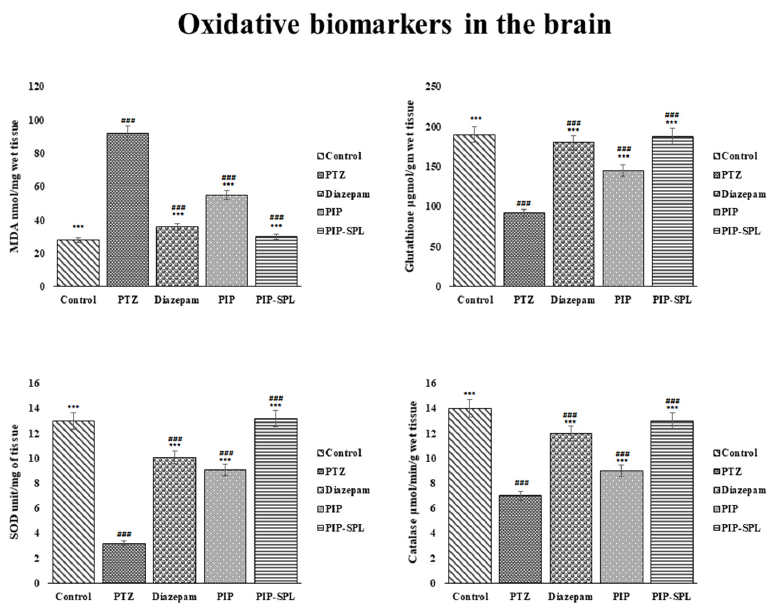
Figure 11. Effect of different treatments on oxidative stress markers of brain (*** indicates that the comparison was made between normal vs. other groups, whereas ### indicates that the comparison was made between control and other groups).